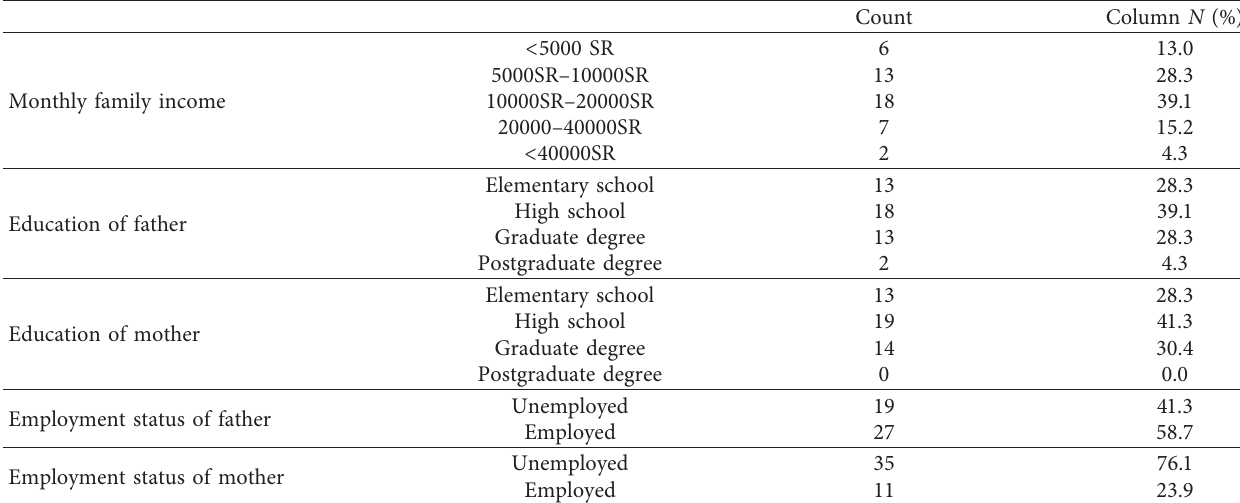
Table 2: Sociodemographic profile of the